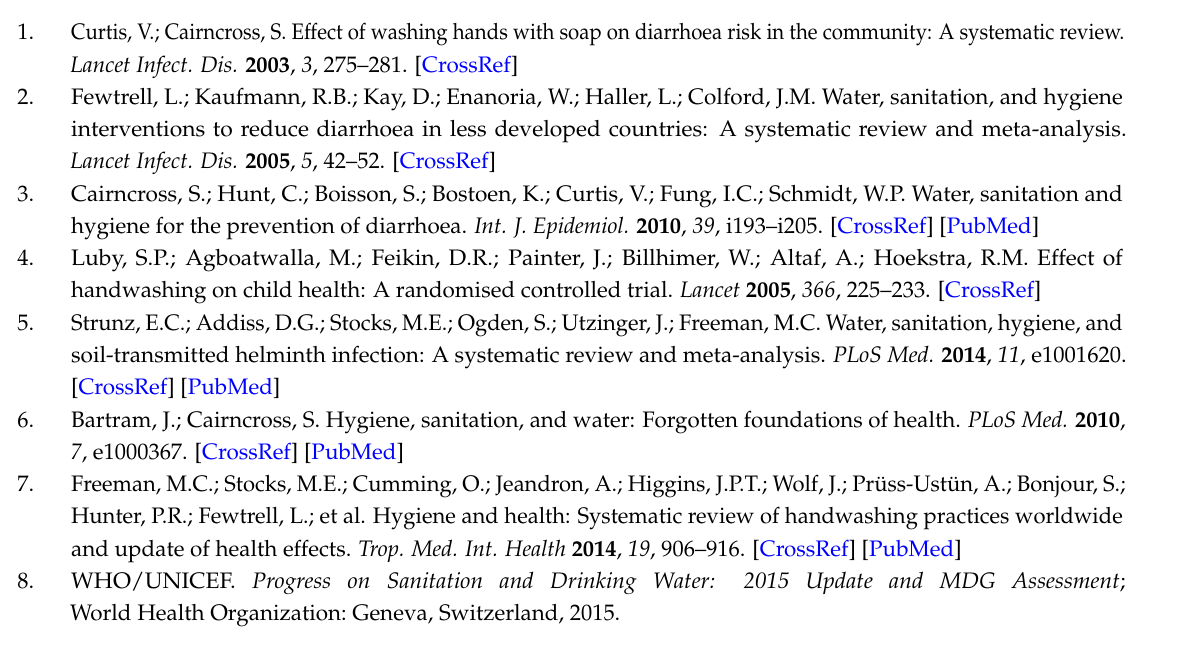
Table S1: Proportion of respondents who wash hands with soap by study